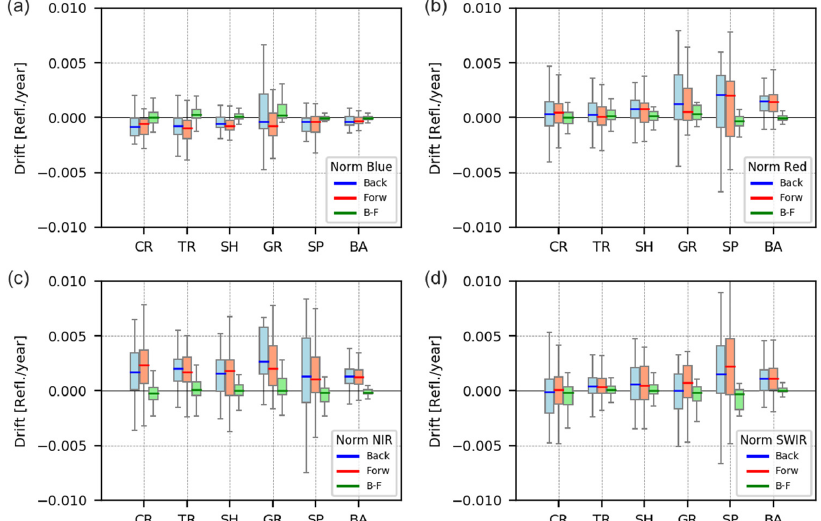
Figure 13. The figure shows boxplots of estimated drifts in BRDF-normalised products aggregated per land cover class for the backward (blue) and forward (red) scattering directions, and their differences (green). Results are presented for bands: ( a ) Blue, ( b ) Red, ( c ) NIR, ( d ) SWIR. Aggregation is performed per land cover class: Crop (CR), Tree (TR), Shrubland (SH), Grassland (GR), Sparse vegetation (SP), Bare soils (BA). The parameters of the boxplot chart are those used and described in Figure 12.